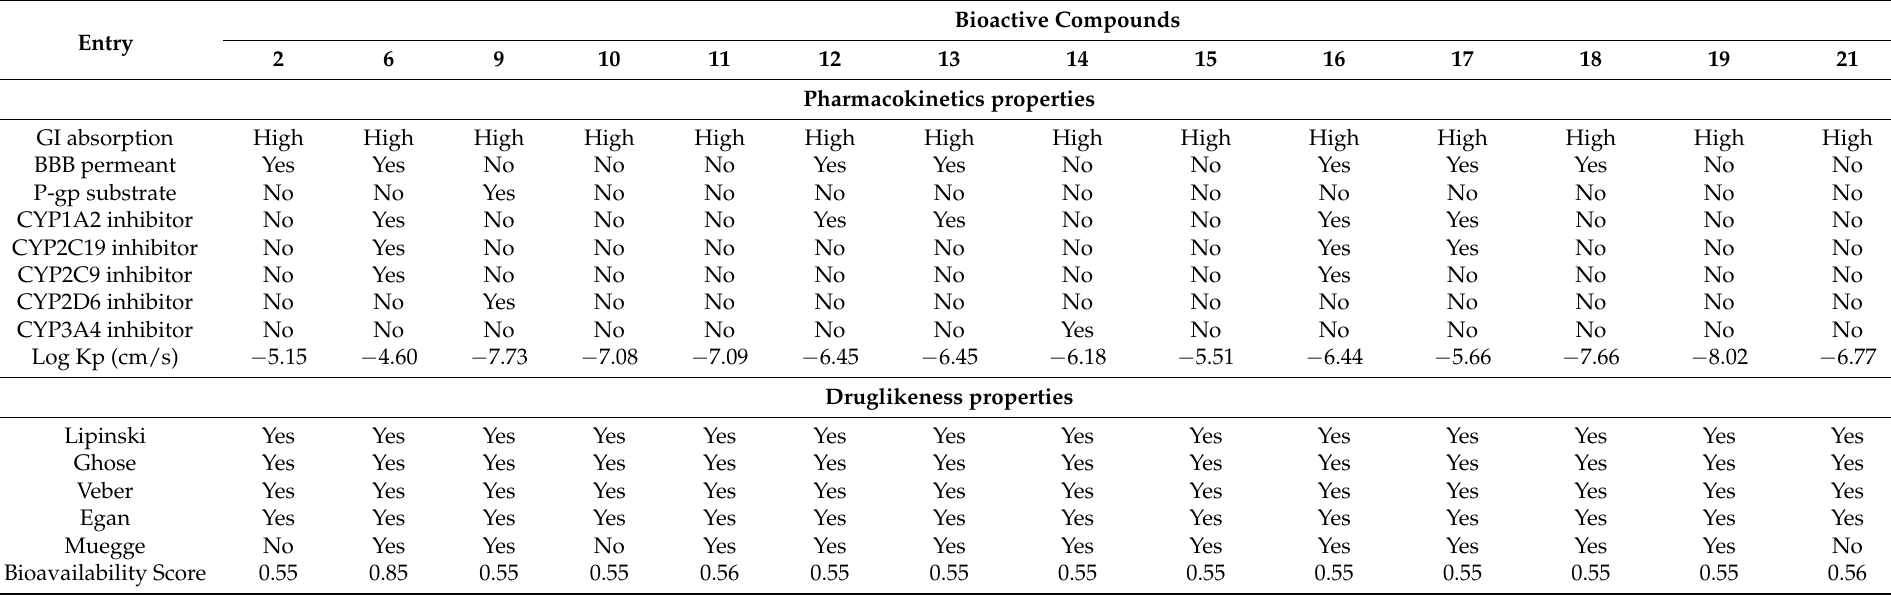
Table 5. Pharmacokinetics, drug-likeness and medicinal chemistry of identified compounds according to SwissADME